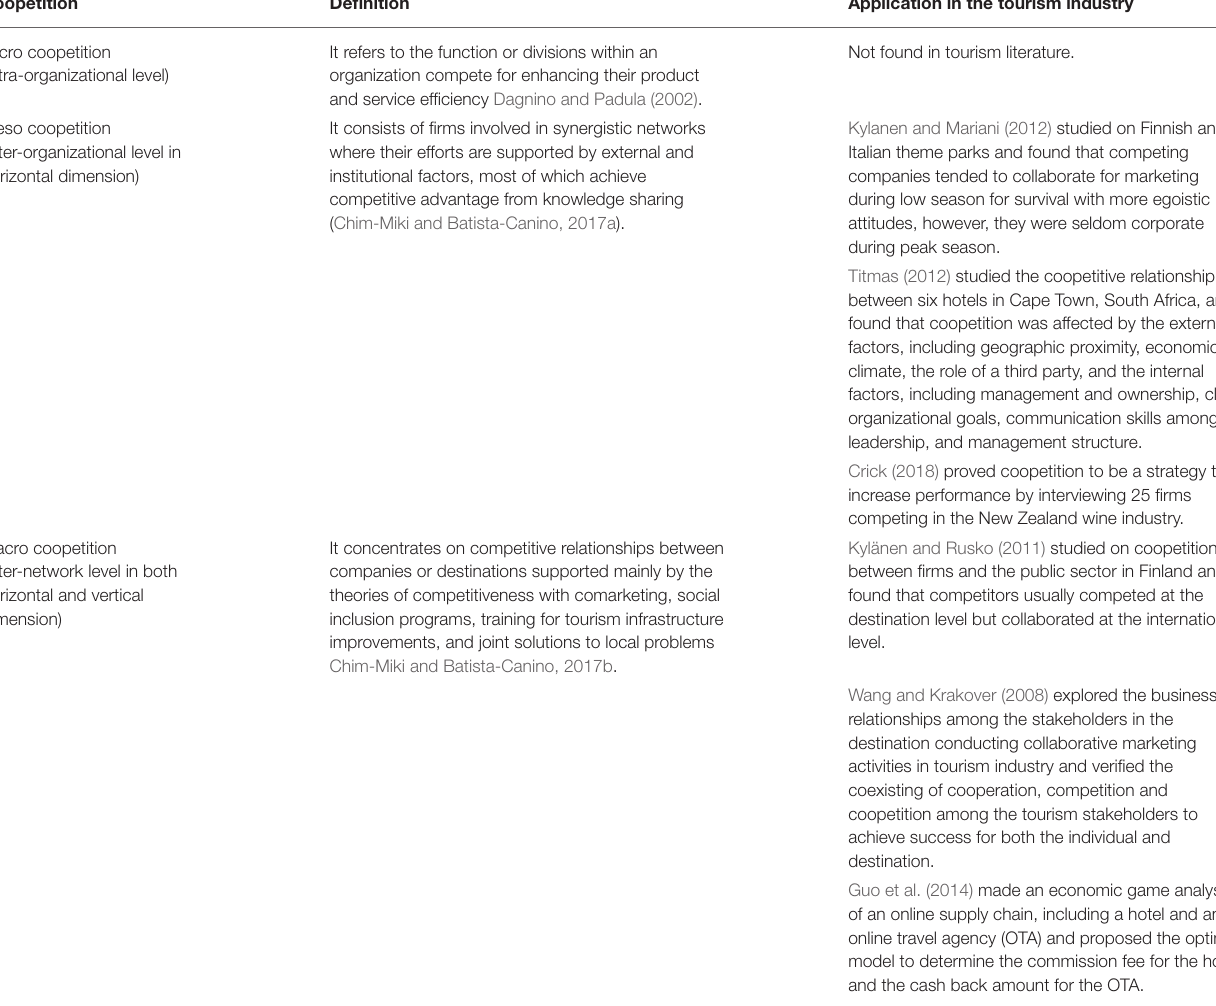
TABLE 1 | Different levels and dimensions of coopetition applied in the tourism